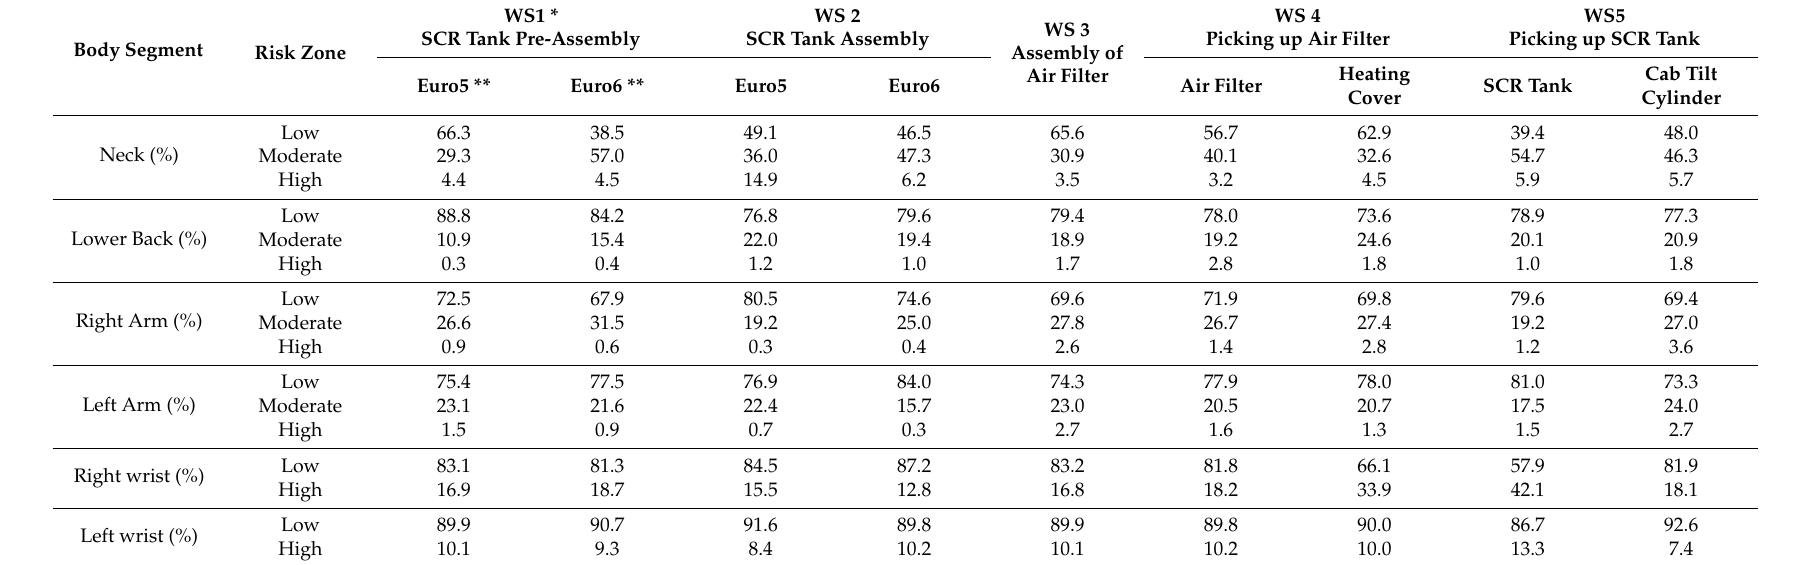
Table 4. The proportion of time in awkward postures (flexion / extension) for workstations (WS) in an assembly plant over one cycle time (8 min) for Improvement Group three (IG3); four measurements performed for each